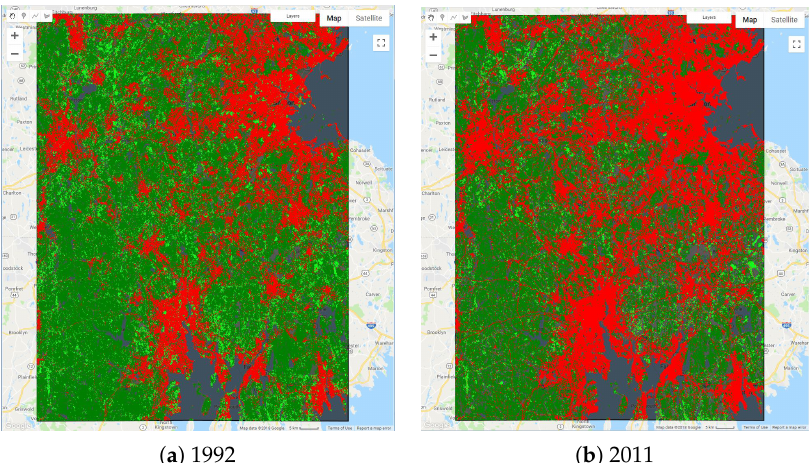
Figure 12. Boston MA: LC situation in 1992 ( a ) and in 2011 ( b ). In red, the Urbanized class, in light green, the Cultivated class, in dark green, the Forest and Shrubland classes.